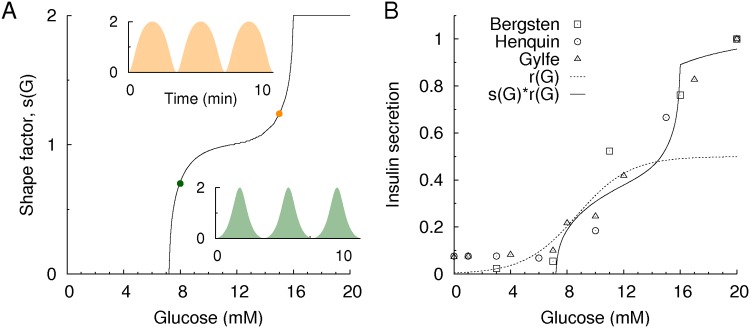
Phase modulation and insulin secretion.(A) Glucose-dependent shape factor, s(G). Phase-modulated time traces of Ca2+ oscillations at 8 mM (green) and 15 mM (orange) glucose. (B) Insulin secretion (solid line), s(G)⋅r(G), decomposed into the shape factor, s(G), and amplitude (dotted line), r(G). The symbols represent experimental data from Bergsten [41] (square), Henquin [42] (circle), and Gylfe [43] (triangle). The insulin secretion is normalized to have a maximal value at 20 mM glucose.